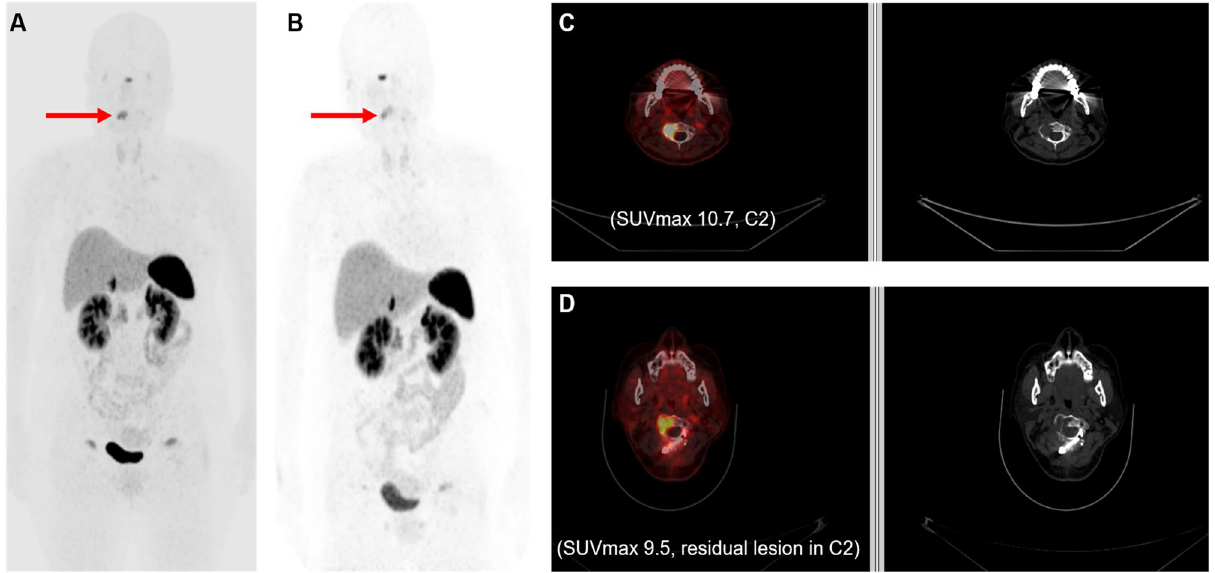
Figure 2. A case of unresolved hypophosphatemia after surgical excision was demonstrated by the follow-up with 68 Ga-DOTATOC PET/CT. ( A ) MIP image of initial 68 Ga-DOTATOC PET/CT with the red arrow indicating the culprit lesion; ( B ) MIP image of follow-up with 68 Ga-DOTATOC PET/CT 6 months after surgery with the red arrow indicating the residual culprit lesion; ( C ) axial PET/CT and non-enhanced CT images of culprit lesion in initial 68 Ga-DOTATOC PET/CT; ( D ) axial PET/CT image and non-enhanced CT images of residual culprit lesion in follow-up 68 Ga-DOTATOC